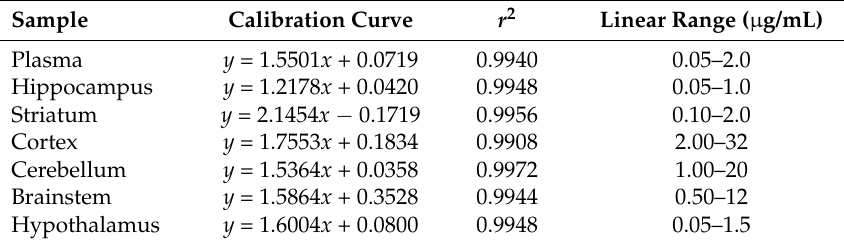
Table 1. Calibration curve, correlation coefficient ( r 2 ) and linear range of DDIE in rat plasma and cerebral nucleus